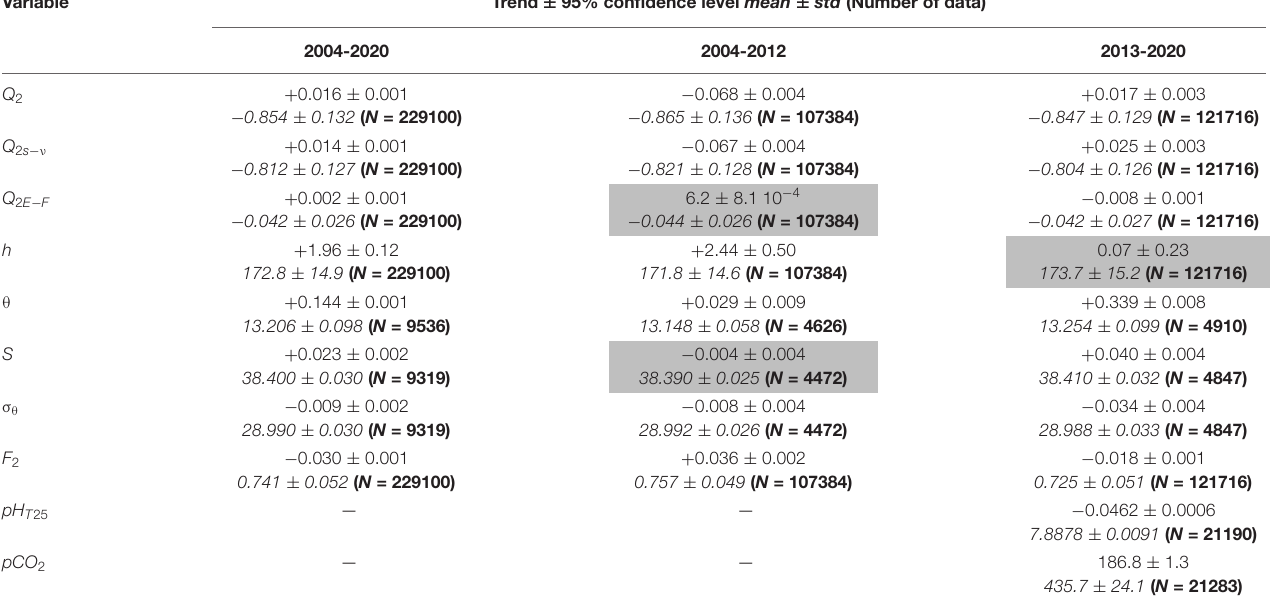
TABLE 1 | Summary of estimated trends (with 95% confidence level), mean and std (in italics) and number of data used in each calculation (in bold in brackets) for different variables of the study: Q 2 is the total outflow, Q 2 s − ν is the slowly part of it and Q 2 E − F is the tidally driven contribution of the eddy-fluxes; h is the interface height, θ is the potential temperature, S the salinity, σ θ the density anomaly, F 2 the lower layer Froude number, pH T 25 the seawater pH and pCO 2 the CO 2 partial pressure. Variable